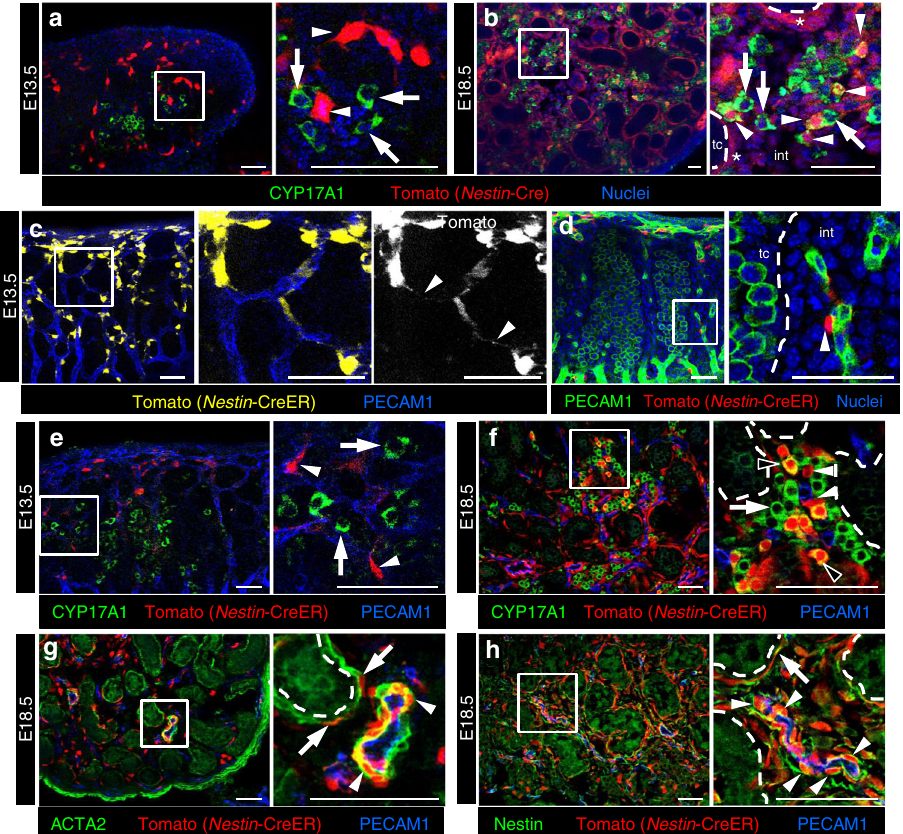
Fig. 4 Perivascular Nestin-expressing cells are multipotent progenitors. Immuno fl uorescence images of E13.5 ( a ) and E18.5 ( b ) Nestin -Cre; Rosa -Tomato and E13.5 ( c – e ) and E18.5 ( f – h ) Nestin -CreER; Rosa -Tomato fetal testes exposed to tamoxifen at E12.25. At E13.5, the initial cohort of differentiated Leydig cells, as marked by CYP17A1 ( a , e , arrows), were mutually exclusive from Tomato-lineage-traced Nestin -Cre-expressing cells ( a , e , arrowheads). By E18.5, a subset of Tomato-labeled cells ( b , arrowheads) expressed CYP17A1 (Tomato-negative FLCs are marked with arrows in ( b , e , f )). Asterisks in ( b ) indicate Tomato expression in peritubular myoid cells and dashed lines in ( b , d , f – h ) indicate testis cord (tc) – interstitium (int) boundaries. In E13.5 Nestin -CreER; Rosa -Tomato fetal testes exposed to tamoxifen at E12.25 ( c – e ), initial Tomato-labeled cells were adjacent to the vasculature and extended long processes along the length of blood vessels ( c , d , arrowheads), but no Tomato-positive cells were observed in the rest of the interstitial mesenchyme ( d ). By E18.5 ( f – h ), a subset of FLCs expressed Tomato ( f , black arrowheads), in addition to peritubular myoid cells ( g , arrows), vascular smooth muscle ( g , arrowheads), and undifferentiated, Nestin-immunopositive perivascular cells ( f , h , white arrowheads). Thin scale bars, 50 μ m; thick scale bars, 10 μ